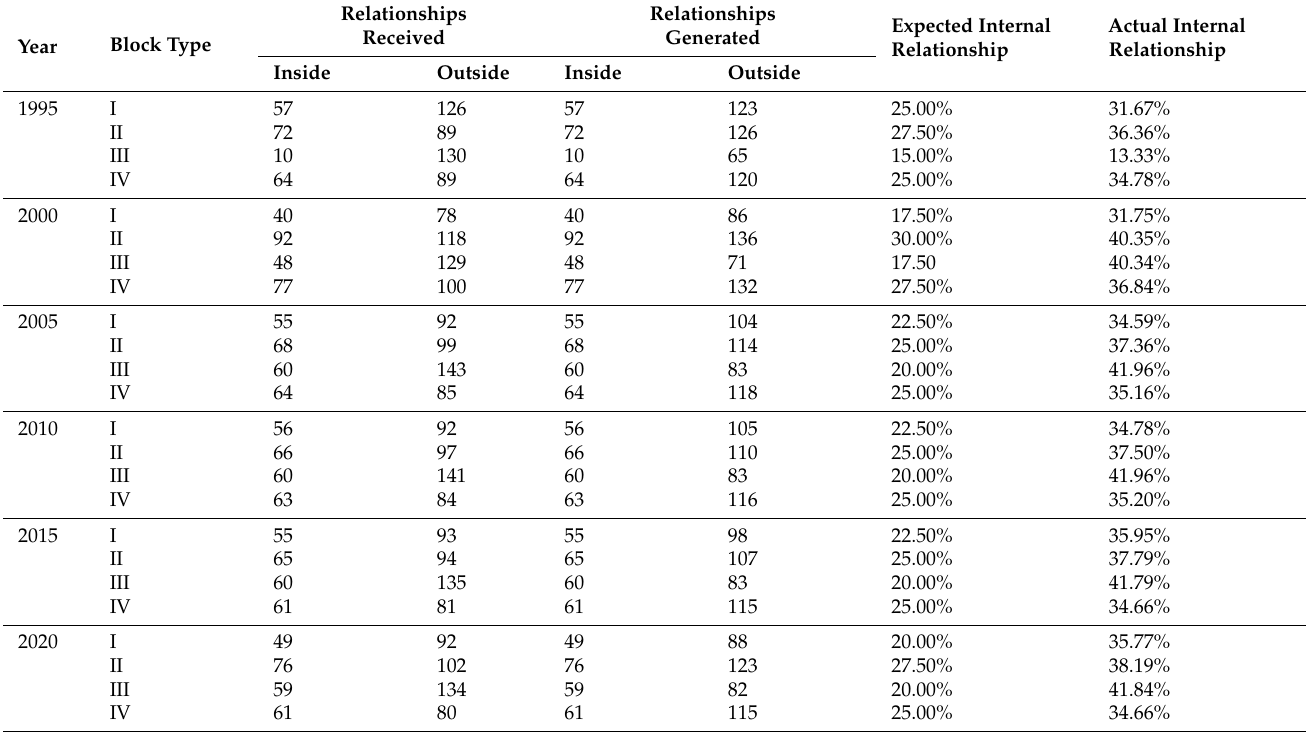
Table 2. Spillover effects of land pressure in the